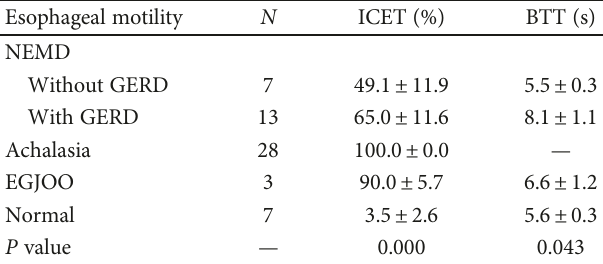
Table 3: Impedance results of esophageal manometry in 58 NOD